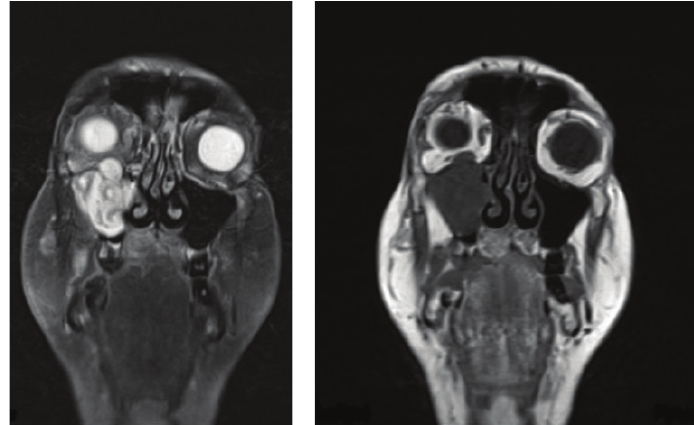
Figure 2: Postgadolinium MRI coronal sequence showing superior extension into the right